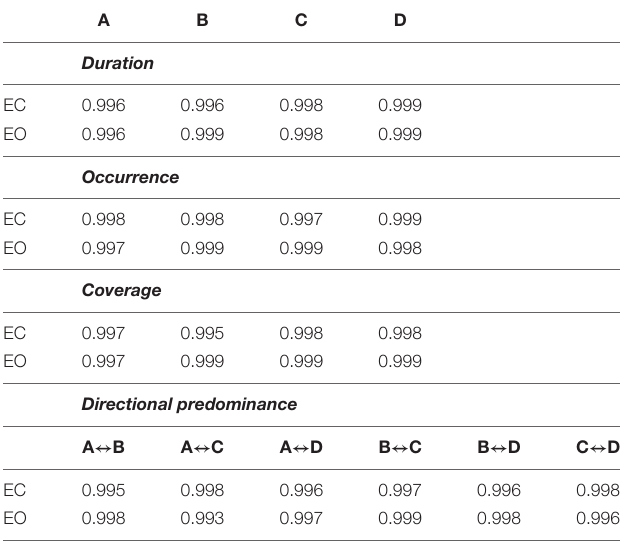
TABLE 2 | Consistency between microstate parameters extracted from multichannel EEG dataset denoised by means of the visual inspection approach and the automated approach.